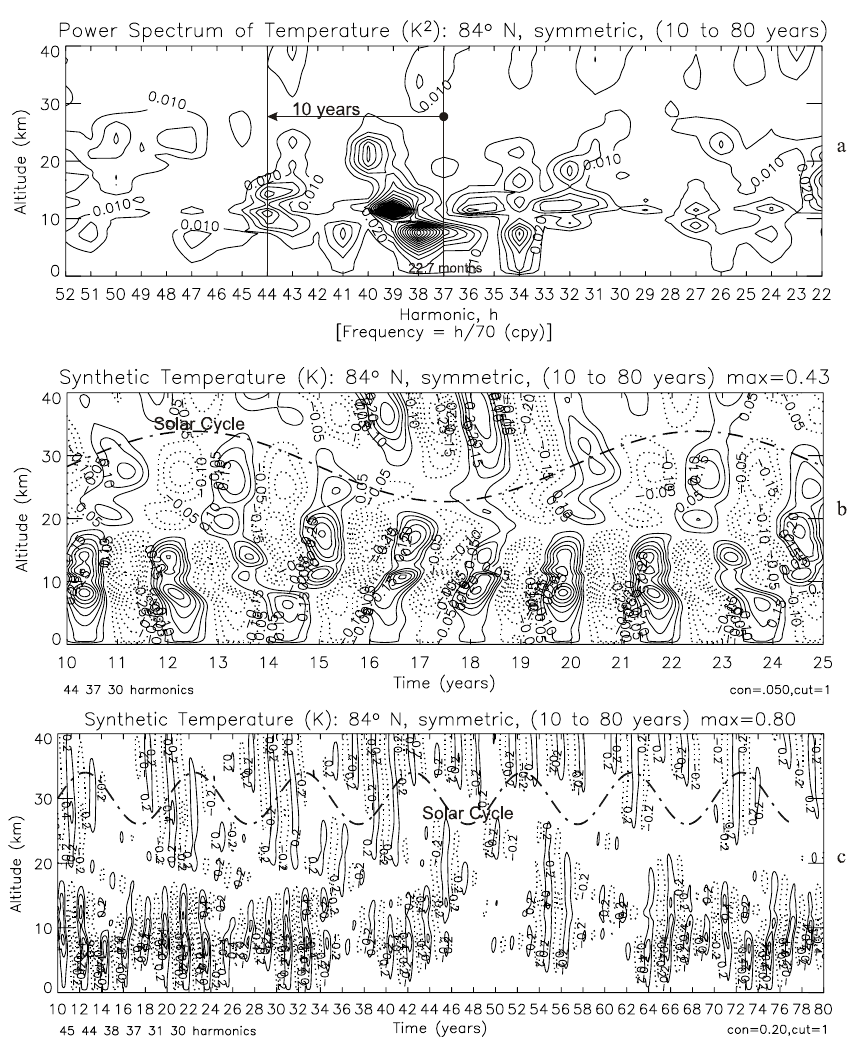
Fig. 6. (a) Similar to Fig. 5a but for the model run from 10 to 80 years. Assuming that the oscillation originates at equatorial latitudes, the identified spectral features are consistent with the dominant QBO at h =37 in Fig. 4c. The synthesis (b) then employs the harmonics h =37 and 37 ± 7 to describe the average SC modulation of the QBO. The amplitude maximum in (a) however does not occur at h =37 (for the equator) but at h =38 instead, shifted by one wave number to indicate that the QBO at high latitudes is varying significantly over the time span of 70 years. This variability is evident in the synthesized temperature (c) , which employs the harmonics h =37 and 37 ± 7, combined with h =38 and 38 ±